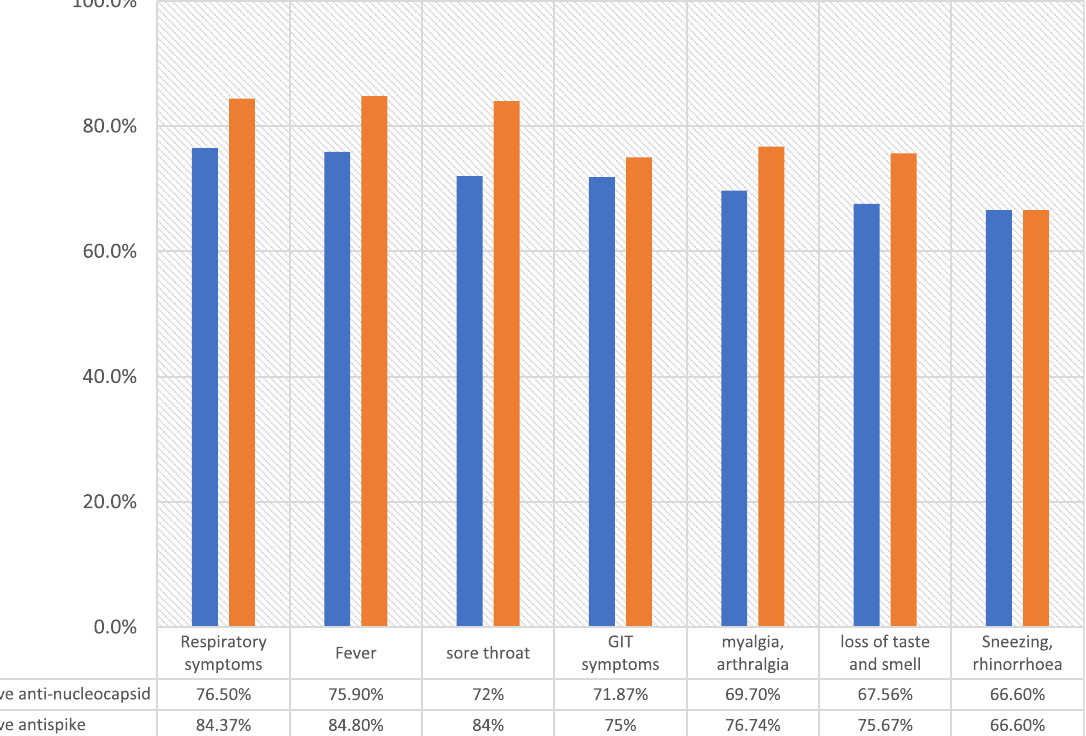
Fig. 1 Clinical symptoms at initial presentation and antibody positivity (anti-NP and anti-S) of 92 patients with mild-moderate